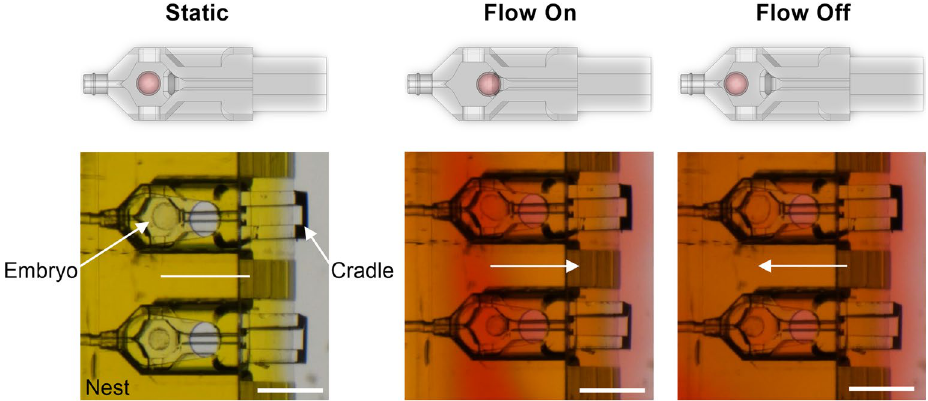
Figure 8. Mouse embryo movement in a changing dynamic flow environment with the introduction of red stained medium (Scale bars = 300 µm; 1 rep, n = 8). ( A ) Static conditions show the expanded blastocysts housed inside the cradles and nest after 48 h of culture; ( B ) Flow On shows the embryos move to the right as the flow pushed them to the back of the cell chamber; ( C ) Flow Off shows the embryos move to the left back towards the